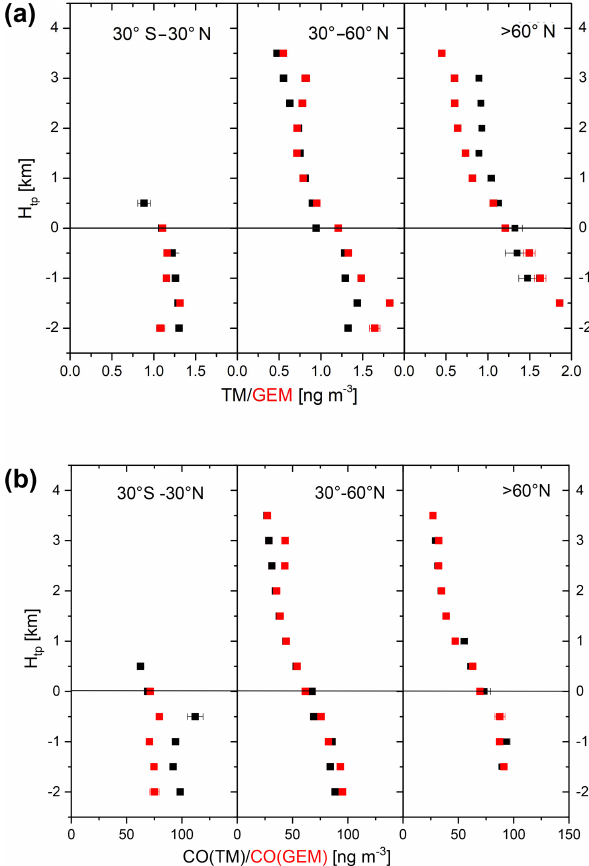
Figure 5. Vertical TM and GEM distribution relative to the ther- mal tropopause in winter (December–May, a ). Panel (b) shows the vertical distribution of CO measured during the TM and GEM mea- surements. The data points represent averages and their standard errors, extreme values were eliminated using the Nalimov outlier test (Kaiser and Gottschalk, 1972).